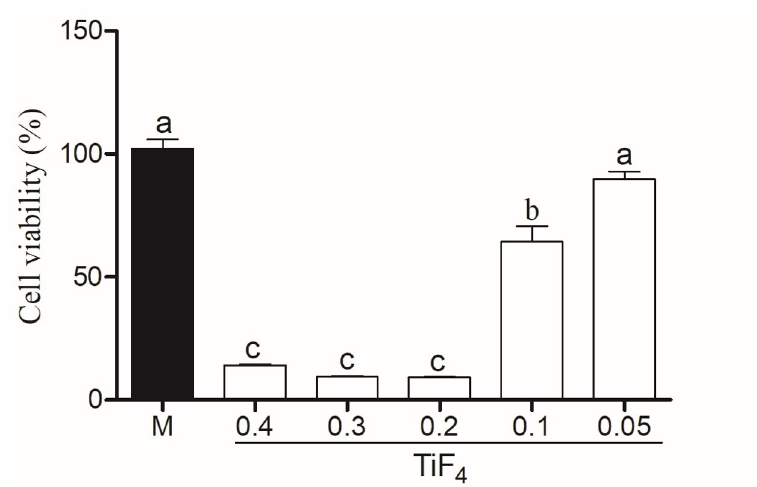
Figure 5. Cell viability of experimental gel with Natrosol, Chemygel, and different concentrations of TiF 4 (0.4, 0.3, 0.2, 0.1, and 0.05 g) compared to medium (control group). Legend: Means followed by different letters indicate statistical differences according to one-way ANOVA with Tukey post hoc test with significant level set at 5%. M: medium; HP: hydrogen peroxide; TiF 4 : titanium tetrafluoride.